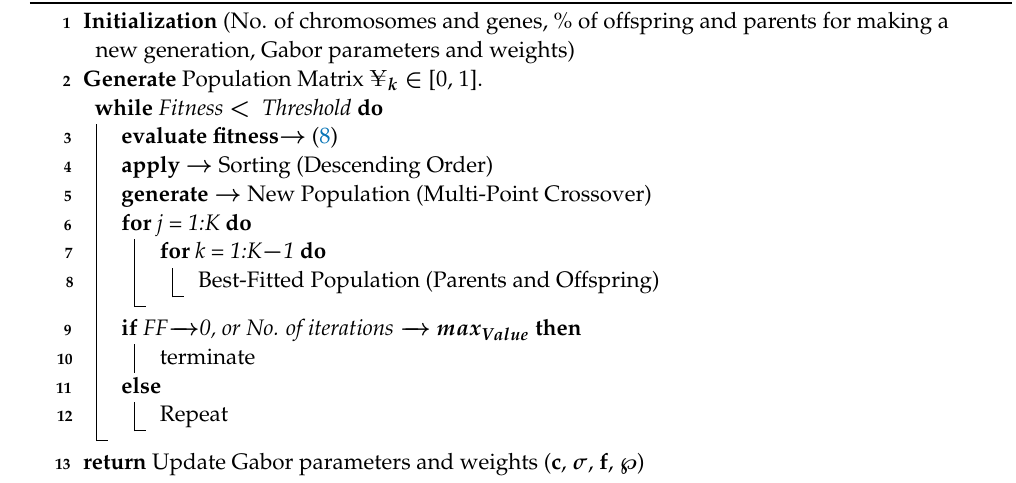
Algorithm 2: GA-based optimal Gabor parameter and weight